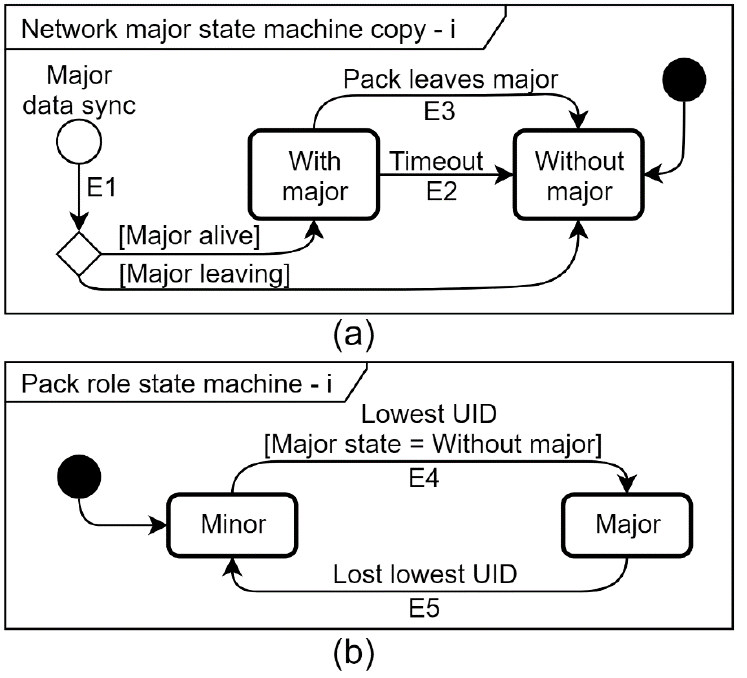
Figure 3. ( a ) i -th copy of the network major state machine and ( b ) pack role state machine of the i -th SRB pack.